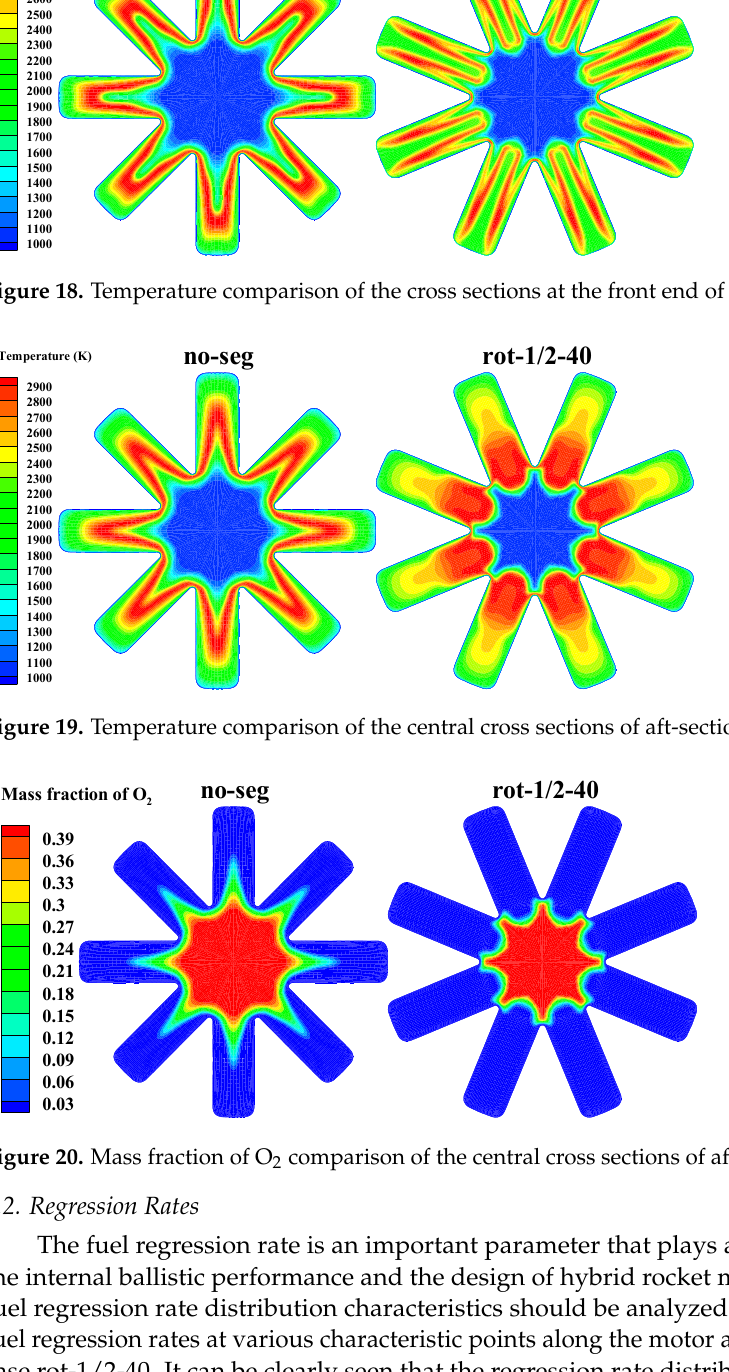
14 of 27 Figure 17. Mass fraction of O 2 distributions in symmetry planes for different cases. The temperature contours in cross sections at the front end of aft-section grain port are illustrated in Figure 18. It is worth noting that there is only a single fuel grain in case no-seg and therefore the cross section shown in Figure 18 is taken at the same axial posi- tion as that in case rot-1/2-40. In case no-seg, the flame in the same slot of the star is sepa- rated into two sections by the front-end face of the aft-section grain. Then, the two parts of flame enter two adjacent slots of the star, respectively, and they distribute along the sides of the star slots, which is evident in case rot-1/2-40 in Figure 18. As the combustion gas moves downstream, the temperature distribution of central cross section of the aft- section grain port is formed, which is shown in case rot-1/2-40 in Figure 19. It can be seen